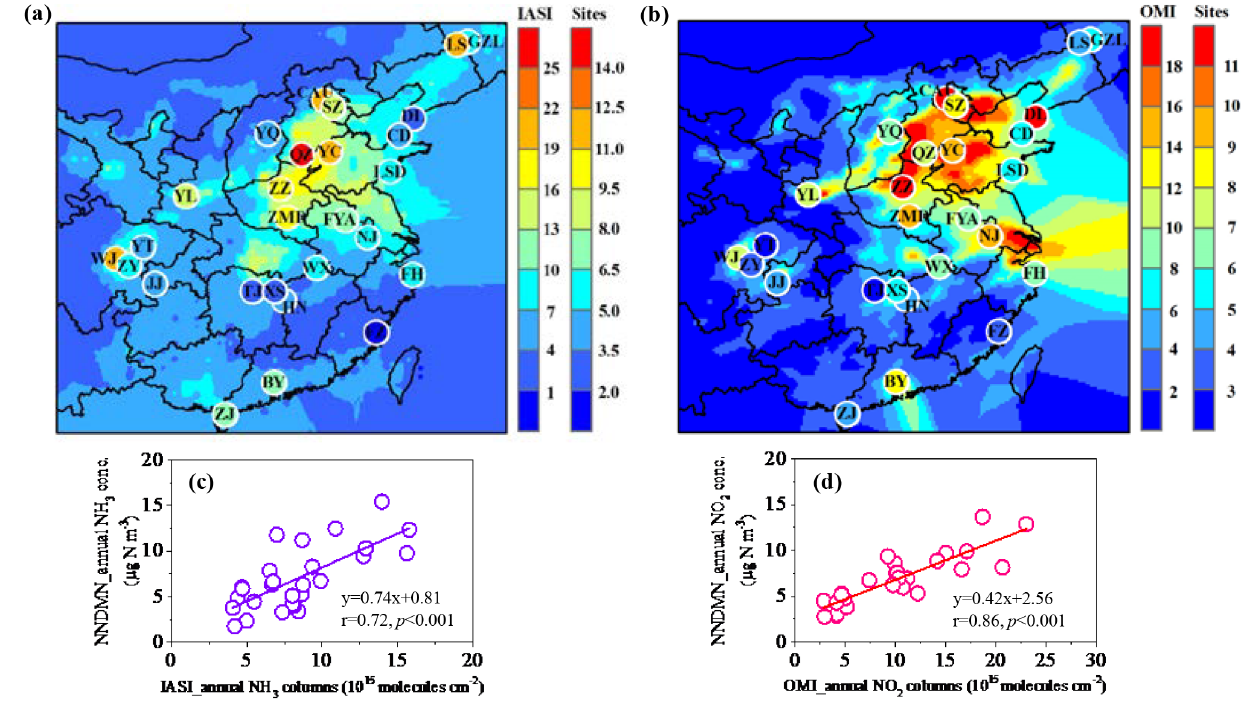
Figure 9. Spatial variation of atmospheric N r in eastern China: (a) NNDMN_NH 3 concentrations vs. IASI_NH 3 columns; (b) NNDMN_NO 2 concentrations vs. OMI_NO 2 columns; (c) relationship of NNDMN_NH 3 concentrations vs. IASI_NH 3 columns; (d) relationship of NNDMN_NO 2 concentrations vs. OMI_NO 2